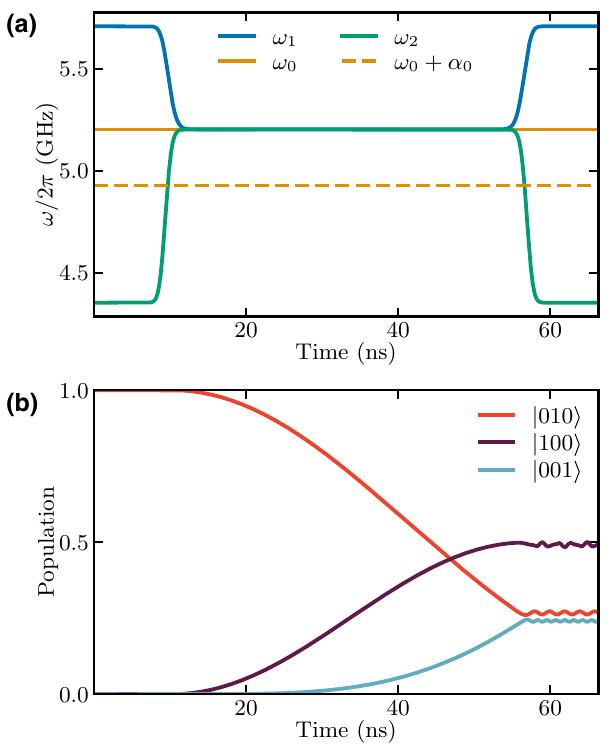
FIG. 14. Implementing the DIV (π/ 4, π/ 2 ) gate with tunable qubits. (a) The tuning of the qubit energies used to realize the gate. (b) Population of the states | 100 (cid:2) , | 010 (cid:2) , and | 001 (cid:2) (the single-excitation subspace) as a function of time during the gate when the initial state is | 010 (cid:2) . As Eq. (61) shows, the effect of the gate is to divide an excitation in one of the outer qubits such that half ends up in the middle qubit and a quarter each in the outer